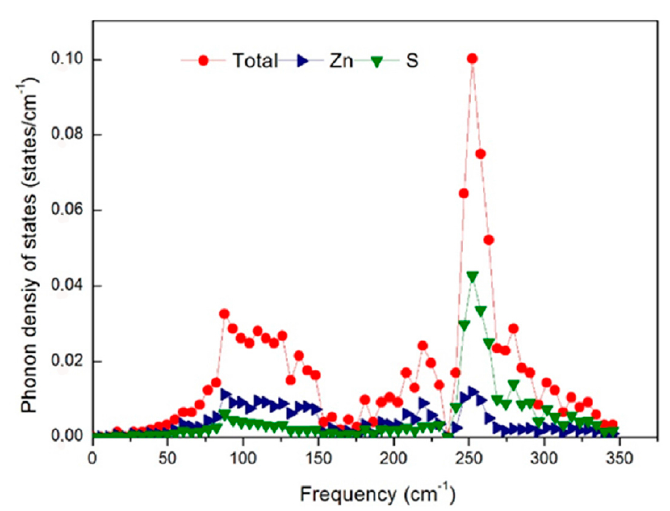
Figure 7. Partial and total phonon density of states of (PDOS) curve of WZ ZnS under zero temperature and